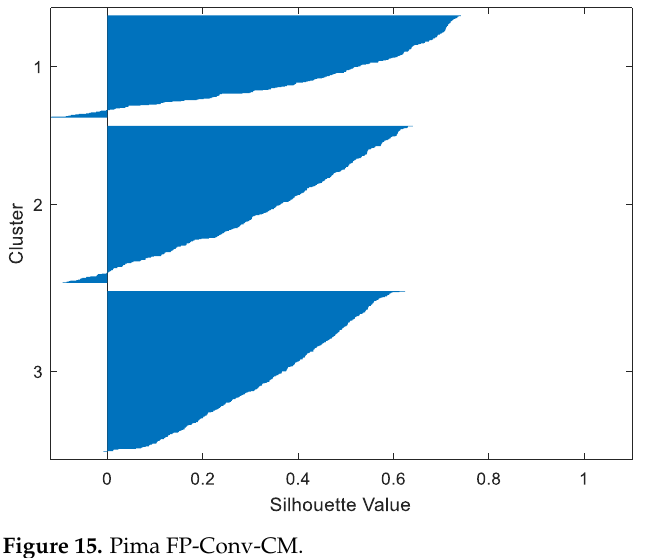
Figure 15. Pima FP-Conv-CM.